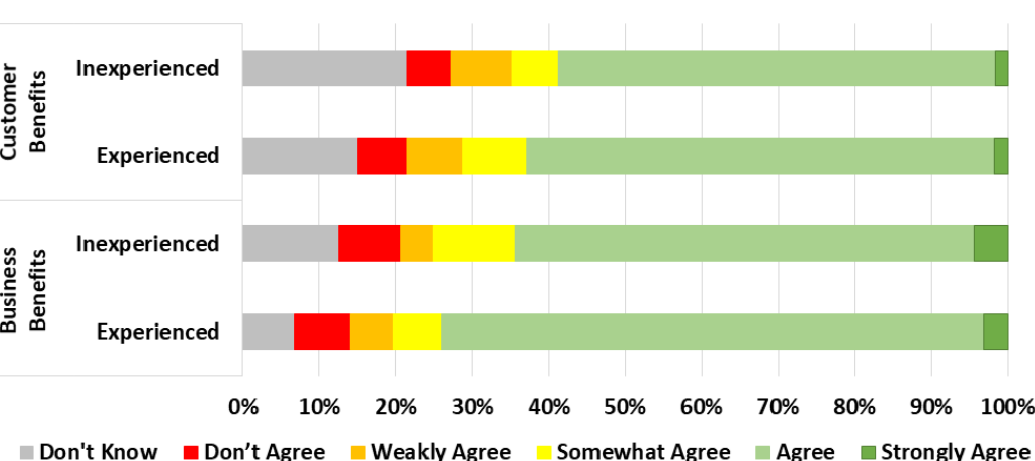
Figure 2. Within each beneficiary group (y-axis), depending on the level of the expert’s experience in digital metering (inner y-axis): the relative percentage response (x-axis) for each agreement level (coloured).